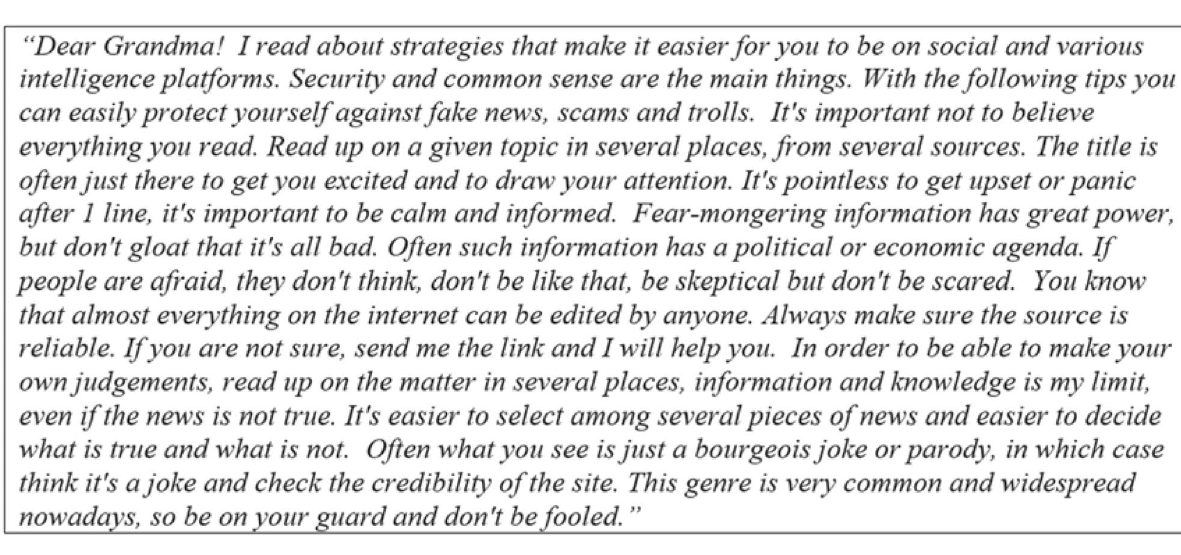
Figure 4. A randomly chosen letter following the above-described instructions (translated by